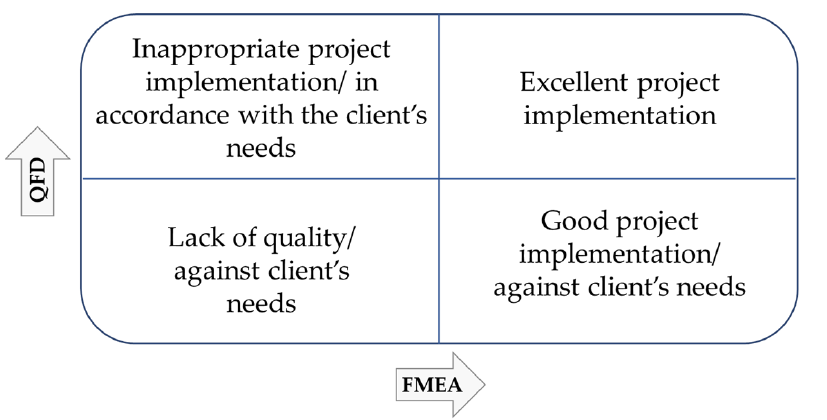
Figure 2. The FMEA and QFD interface.